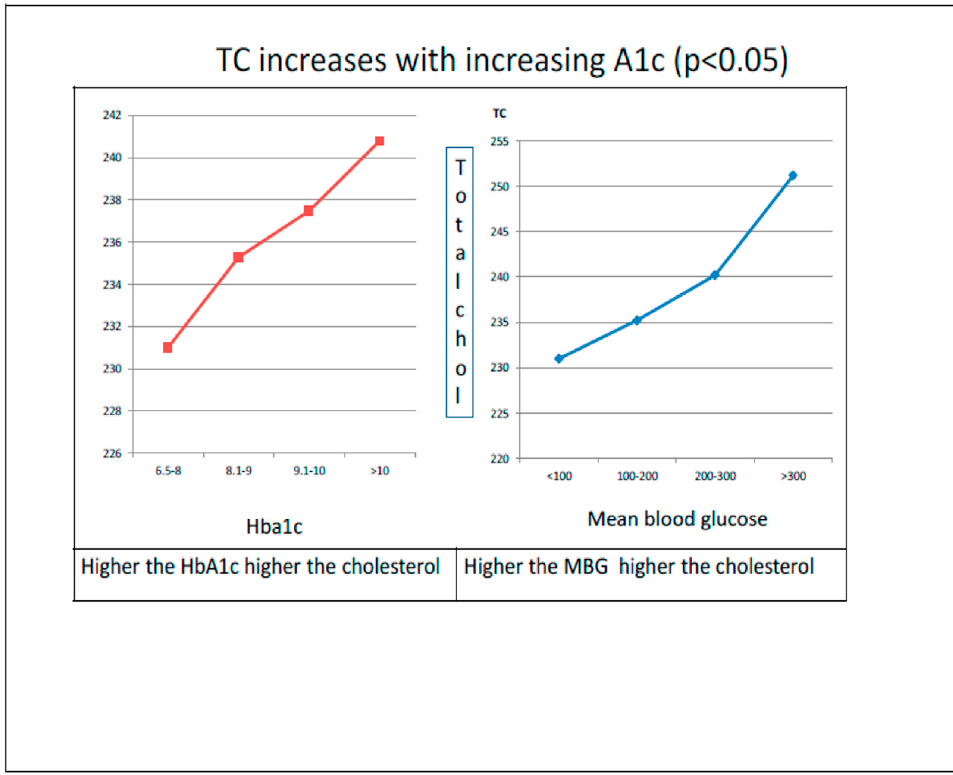
Figure 2. Relationship of HbA1c and hyperlipidemia.